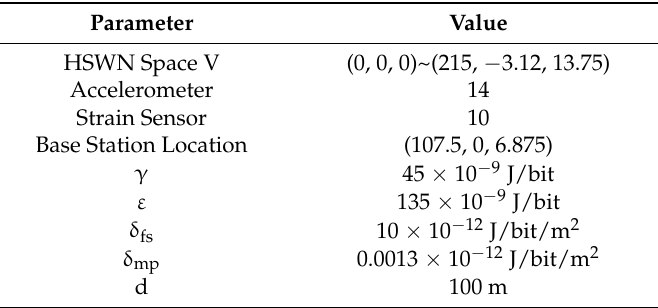
Table 5. Network parameters.